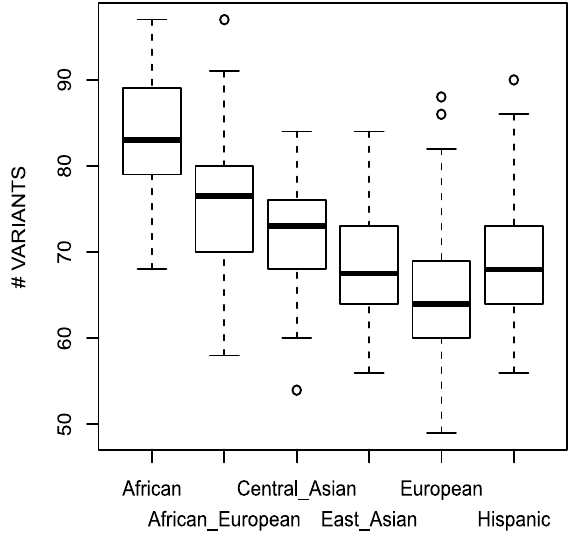
Figure 3. Number of cancer-gene variants per individual by ancestry. The distribution of the number of nonsynonymous genes per subject for each of the 6 ancestry-based subpopulations.